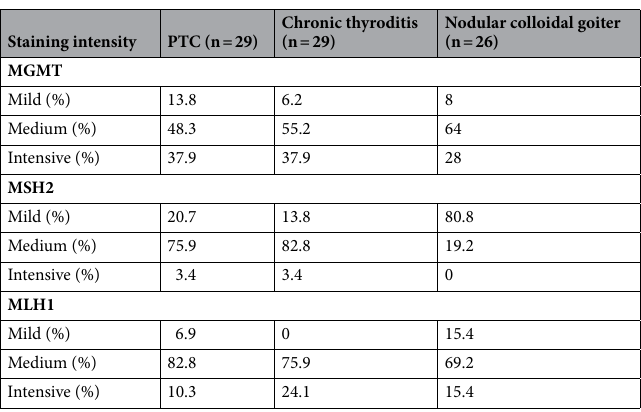
Table 3. Staining intensity ratios of MGMT, MSH2, MLH1 groups.